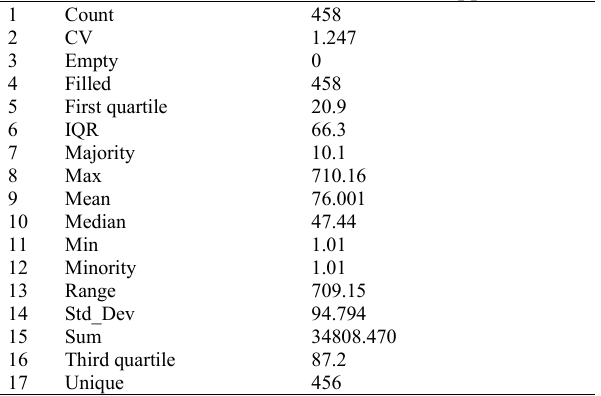
Table 3. Statistical Results from QGIS Application